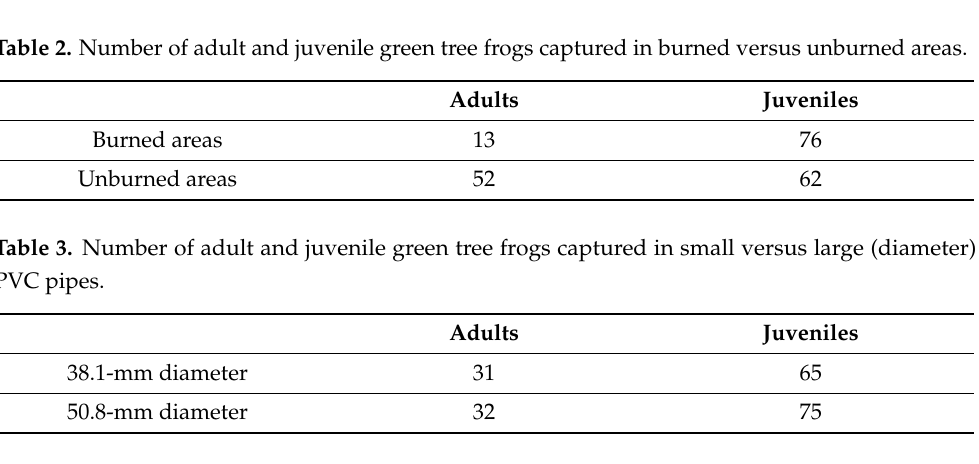
Table 4. Number of adult and juvenile green tree frogs captured in PVC pipes adjacent to, versus 5 m from,